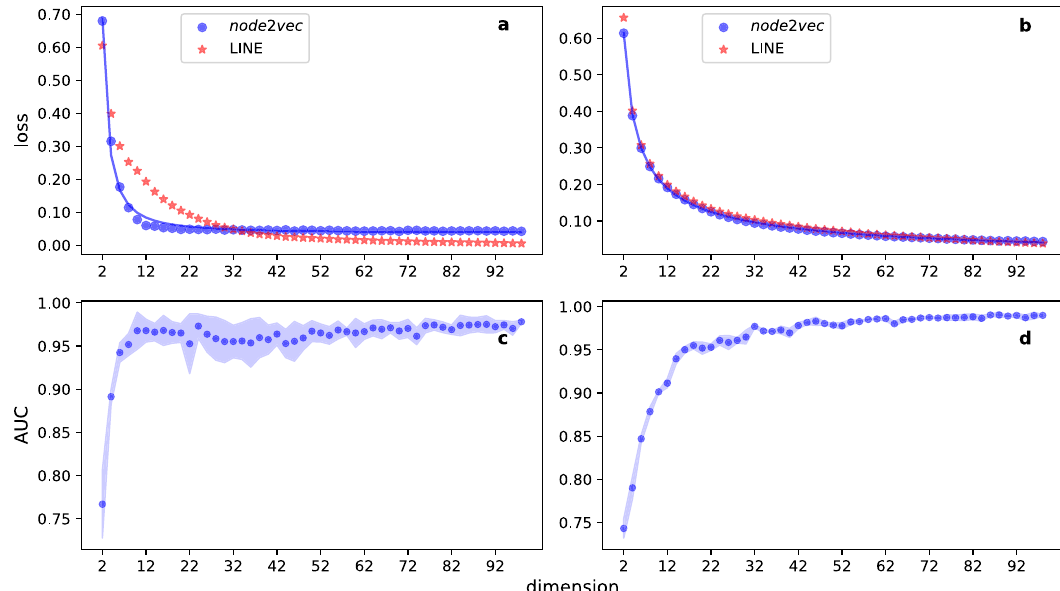
Fig. 1 Geometric embedding of real-world networks. a Normalized embedding loss as a function of the embedding dimension for the American college football network. Blue circles refer to numerical results obtained from node2vec ; red stars refer to embeddings obtained with the LINE algorithm; the blue curve represents the best fi t of Eq. (2) with the data points obtained with node2vec embeddings. We fi nd ^ s ¼ 1 : 806, ^ α ¼ 1 : 468 and ^ L 1 ¼ 0 : 036. The good quality of the fi t is testi fi ed by the fact that the mean-squared error R 2 = 4.252× 10 − 4 . c AUCROC score of link prediction with the node2vec embedding as a function of the embedding dimension for the American college football network. Symbols represent average values of the AUCROC score over 10 random sub-sampling validation tests, while the shaded region identi fi es values within one standard deviation away from the mean. b Same as in ( a ), but for the Cora citation graph. The best fi t of the data points with Eq. (2) is obtained for ^ s ¼ 1 : 030, ^ α ¼ 0 : 801 and ^ L 1 ¼ 0 : 048 (mean-squared error R 2 = 1.113 × 10 − 4 ). d Same as in panel c, but for the Cora citation graph. A similar analysis has been performed for other real-world networks, see Supplementary Fig.